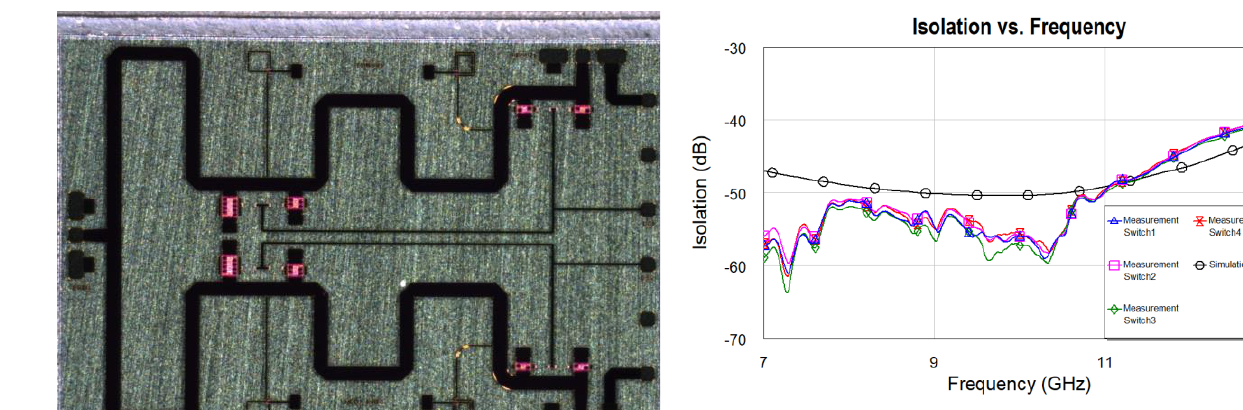
Figure 25: Isolation for the designed switch. Black line simulation. Other lines measurement.